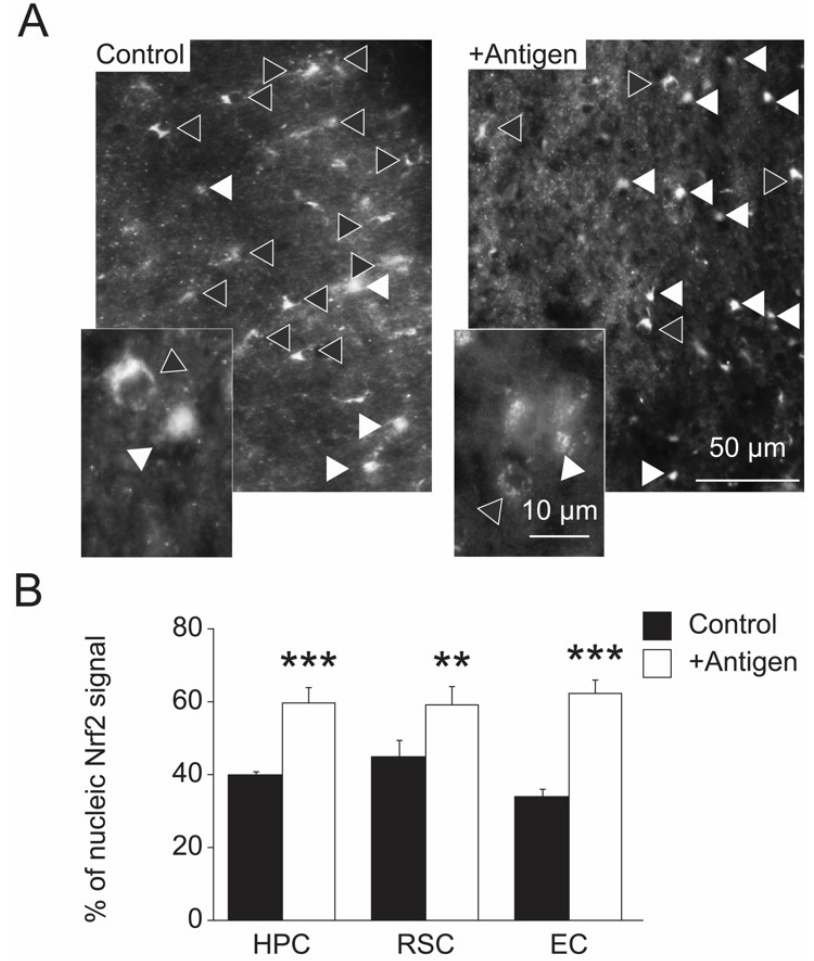
Figure 7. Increased nuclear localization of Nrf2 in antigen-injected mice. ( A ). Hemisphere brains of post-mortem mice (control and antigen-immunized) were dissected, and immunohistochemistry analyses were performed to detect Nrf2 according to the procedure described under the Section 2. The data shows an increased nuclear localization within astrocytes of Nrf2 in a representative image of the EC region of the antigen-immunized compared to the control mice. A similar pattern of Nrf2 localization ratio between the two mouse groups was observed for the HPC and RSC regions (images are not shown). The white triangle symbols point to cells harboring nuclear Nrf2 and the black-filled triangle symbols point to cells harboring cytosolic Nrf2 ( B ). Quantification of the data presented in Panel ( A ) by manually counting the nuclear Nrf2 signal per same-size area in the three selected brain regions. Black and white bars represent control and antigen-injected mice, respectively. Standard deviation is shown for each averaged bar. Data were acquired from five mice per tested group of mice. Statistical analyses were performed using two-tailed student t -test with the following p values: ***, p < 0.001 and **, p <